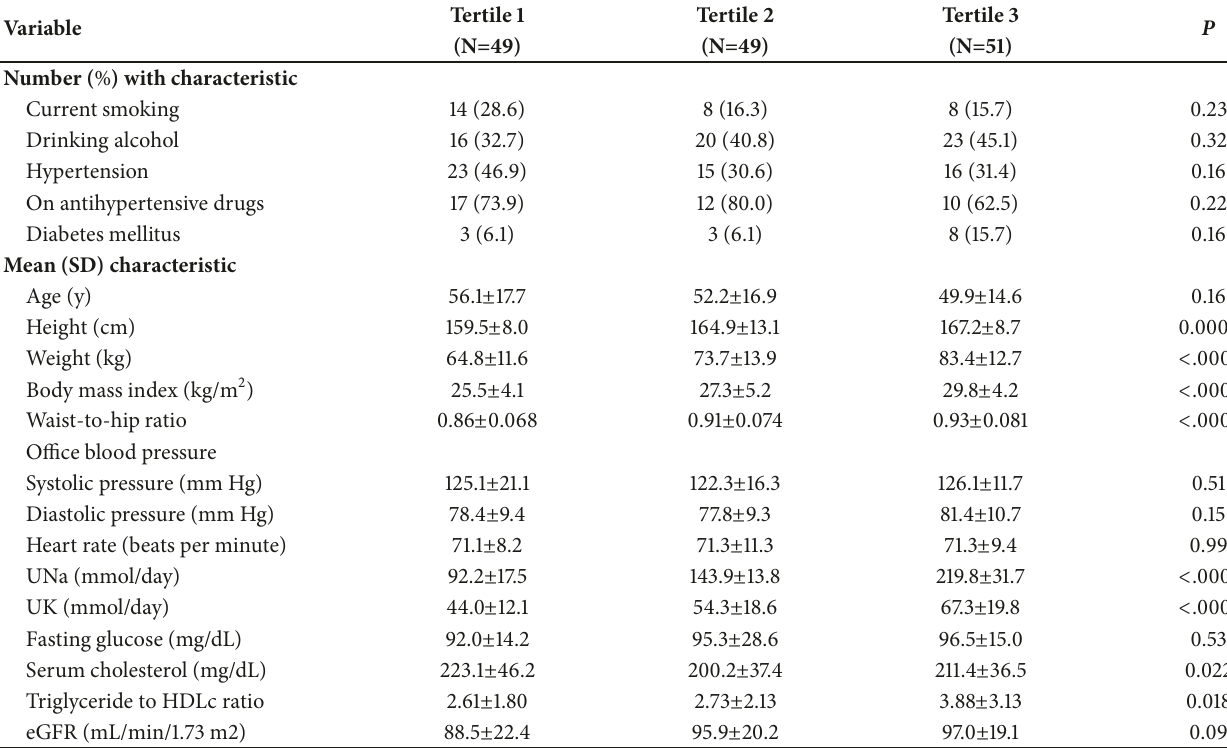
Table 1: Characteristics of participants by tertiles of urinary sodium